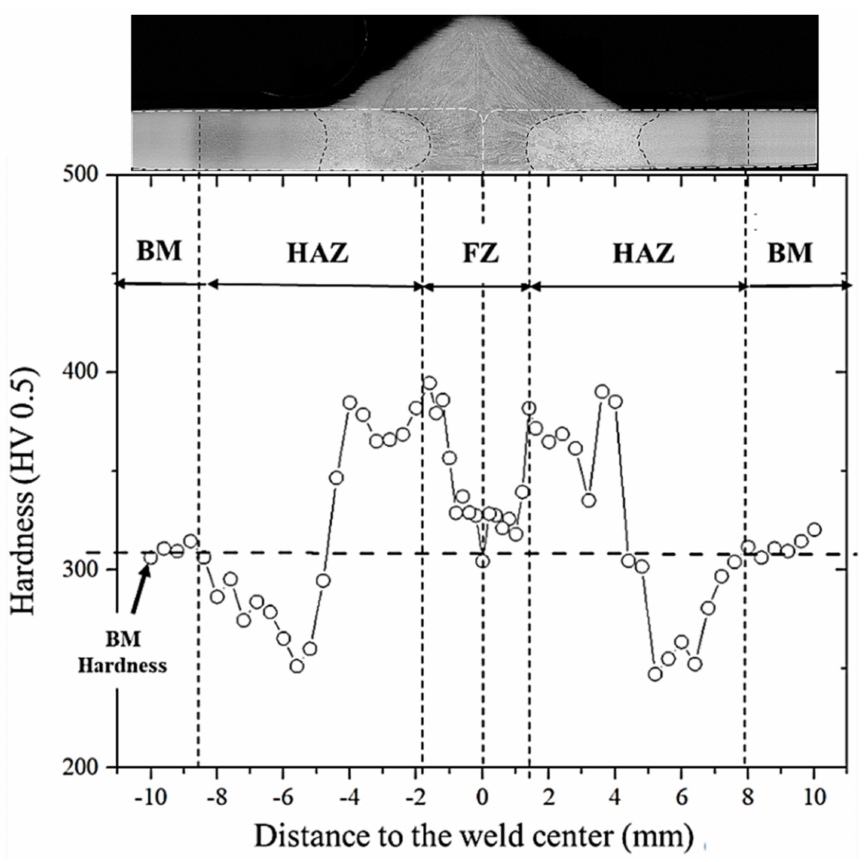
Figure 7. GMAW welded joints of DP980 steel in Vickers scale (HV0.5).